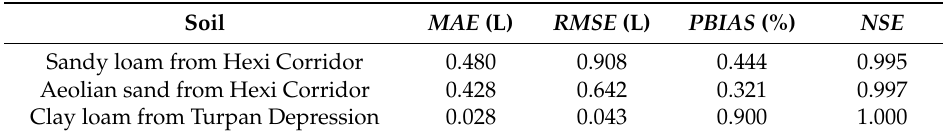
Table 3. Correlation between the measured and calculated values of cumulative infiltration. Soil MAE (L) RMSE (L) PBIAS (%) NSE Sandy loam from Hexi Corridor 0.480 Aeolian sand from Hexi Corridor Clay loam from Turpan